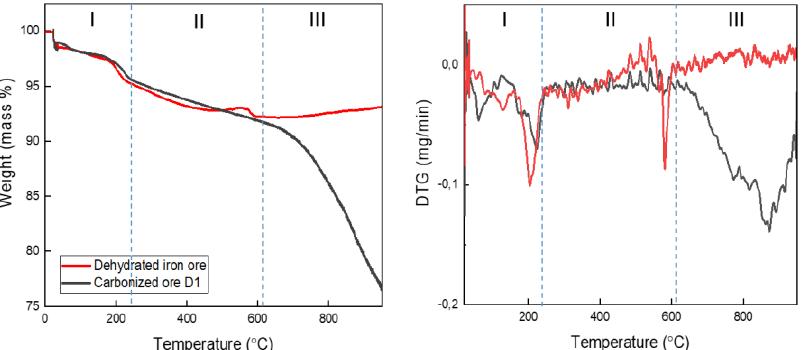
Figure 9. Comparison of the reactivity of carbonized ore and dehydrated ore using thermogravi- metric analysis (TGA) with a heating rate of 10 °C/min under an N 2 atmosphere. The carbon contents of the carbonized ore and dehydrated ore were 19.85% and 2.12% (as shown in Figure 2), respectively. Symbols I, II, III denote first, second, and third stages of weight loss, respectively, in thermogravimetric analysis based on temperature changes.